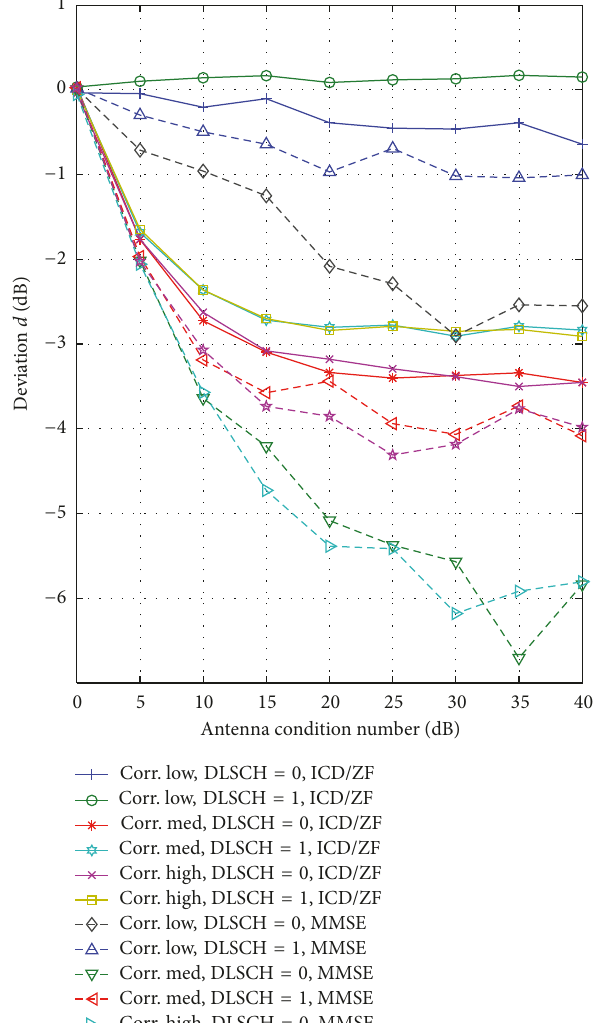
Figure 16: Deviation 𝑑 versus antenna condition number for DLSCH processing on/off, ideal channel estimation; low, medium, and high channel correlation; ICD/ZF and MMSE